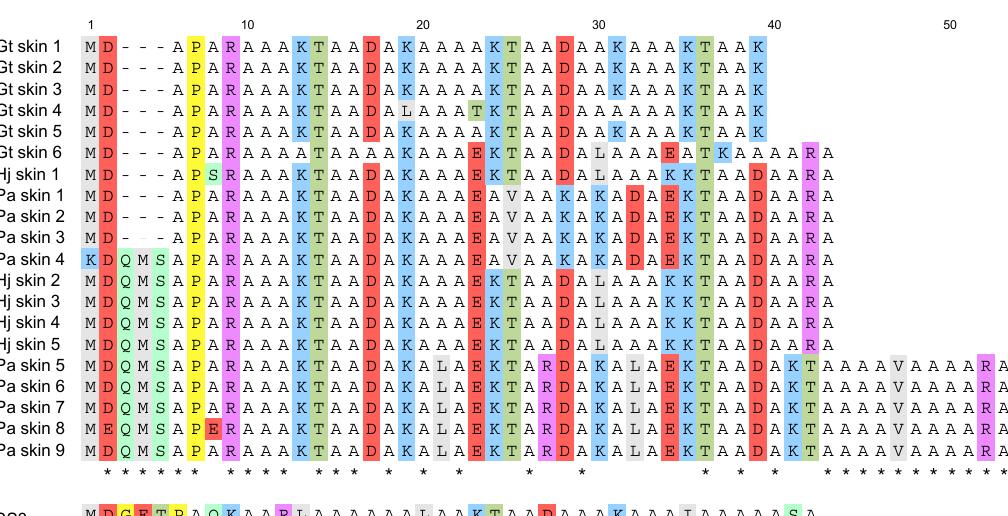
Figure 4. Amino acid sequences of type I antifreeze protein (AFP) from three Cottoidea species, Gymnocanthus tricuspis , Porocottus allisi , Myoxocephalus scorpius (SS3), and Hemilepidotus jordani . Thr are colored green. Polar residues (except Thr) are highlighted light green. Basic residues are highlighted blue (Lys) or purple (Arg), acidic are highlighted red (Asp and Glu), hydrophobic residues (except Ala) are highlighted gray (Met, Leu, and Val) and exceptional residues (Pro and Gly) are highlighted yellow. Hyphen (-) represents gaps. Asterisk (*) indicates the conserved site.